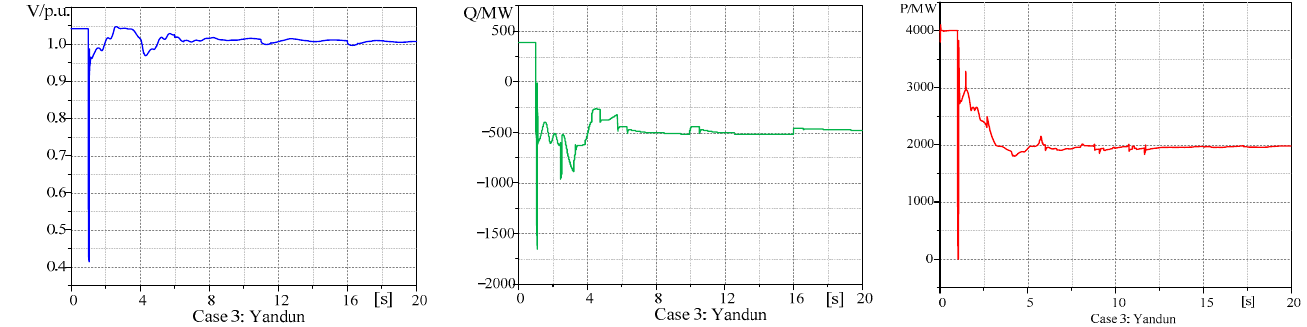
Figure 10. N − 1 simulation of the wind connection system at different stations (Case 1: Santanghu station; Case 2: Hami station; Case 3: Yandun station).